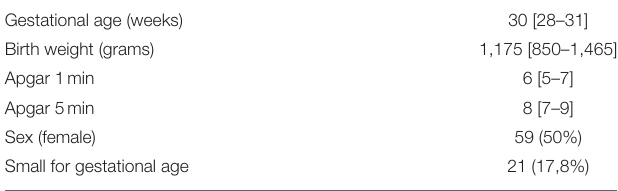
TABLE 1 | Perinatal characteristics of the included patients ( n = 118).